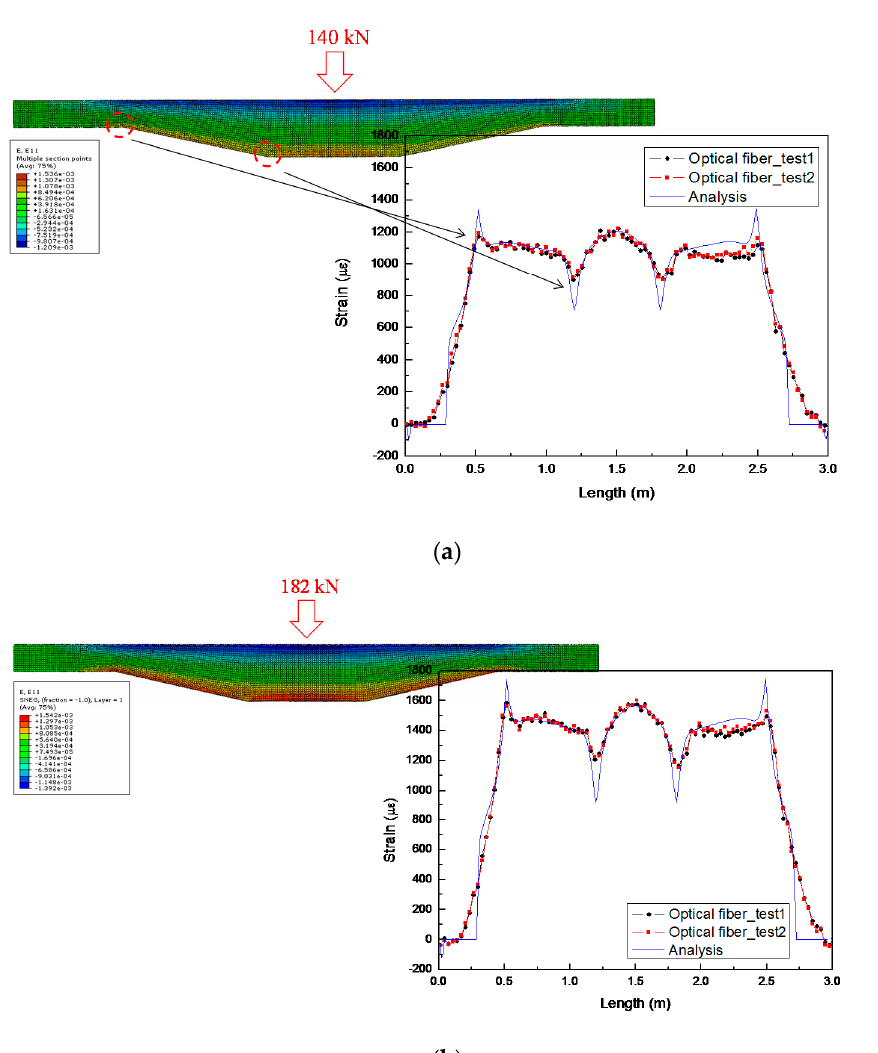
Figure 8. Comparison of finite element (FE) analysis and strain distribution measurement results for a composite side beam with a: ( a ) 140 kN vertical load; and ( b ) 182 kN vertical load.